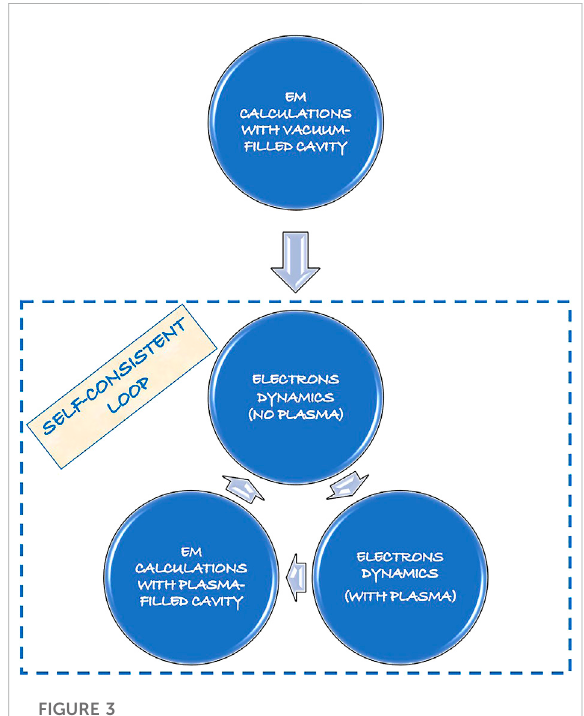
FIGURE 3 Schematic representation of the self-consistent